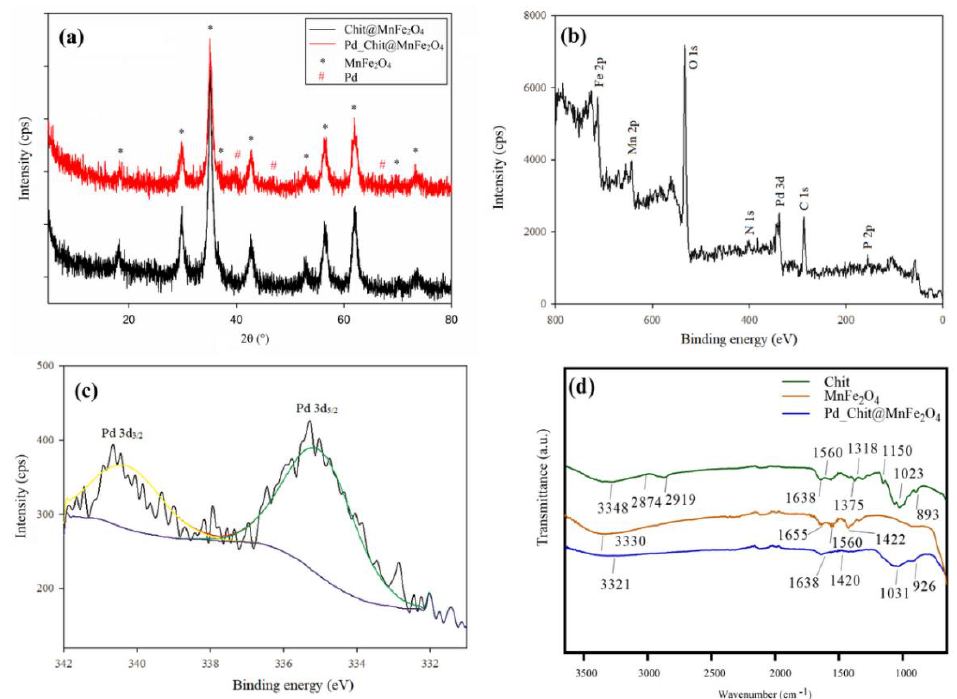
Figure 1. ( a ) XRD patterns, ( b ) wide scan XPS spectrum, ( c ) Pd 3 d high resolution XPS spectrum and ( d ) FTIR spectrum of Pd-Chit@MnFe 2 O 4 .